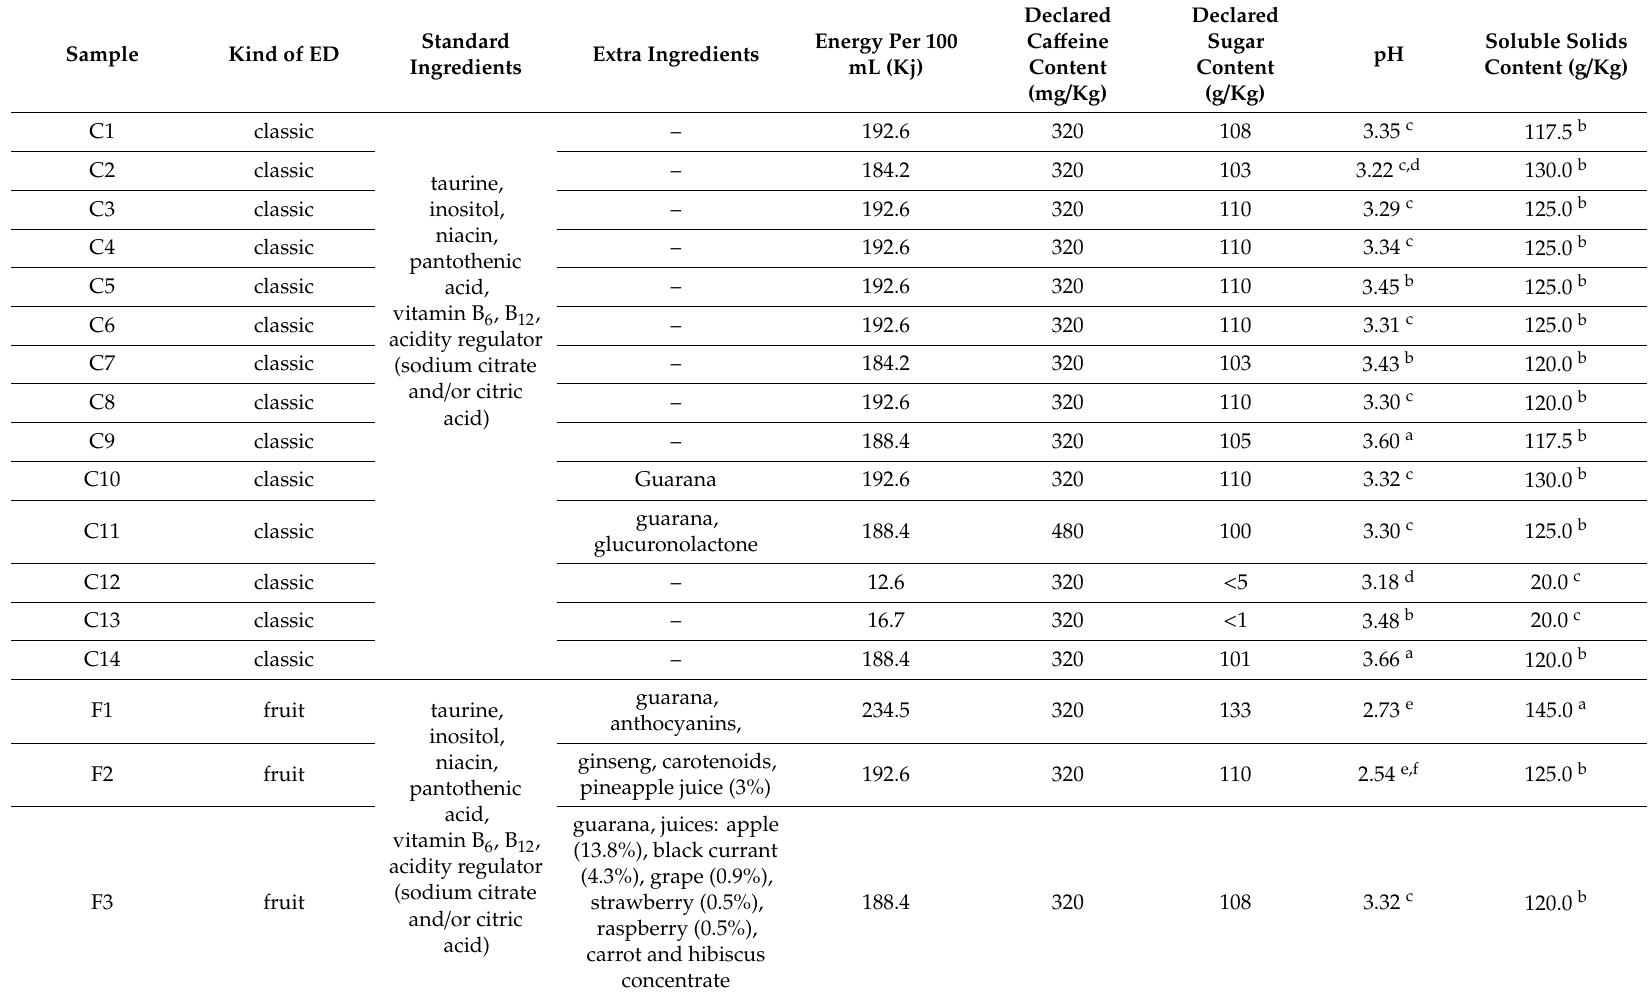
Table 1. Characteristics of the analyzed energy